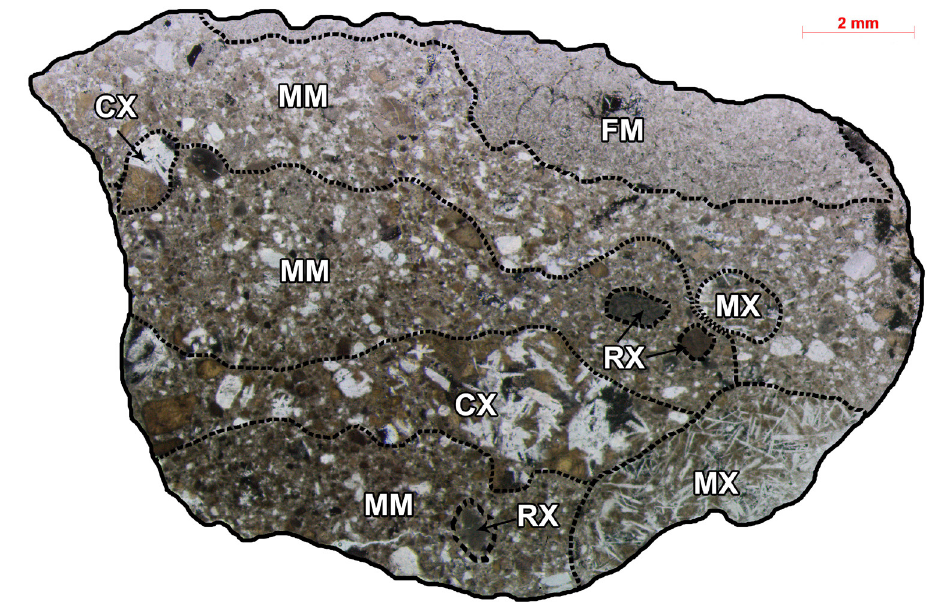
Figure 2 - Picture of a thin section in transmitted light. A variety of light and dark angular clasts range in size from millimeters to centimeters. The lithologies are outlined with dashed lines for better visualization. The matrix and clasts are identified by letters as indicated in the text of the paper. White areas are plagioclase, medium brown areas are clinopyroxene and small black spots are melts and opaque minerals. The abreviations are those presented in figure